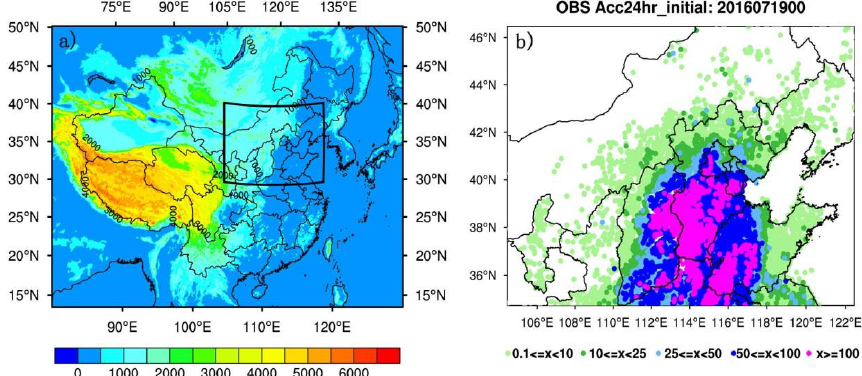
Figure 1. ( a ) Two nested domains in the rapid-refresh multi-scale analysis and prediction system—short-term (RMAPS-ST) with terrain elevation (m). The outside domain covered the China region and the nested domain, mainly located in North China (the inner black box). ( b ) Observations of 24-h accumulated rainfall on July 19, 2016, from ground stations.